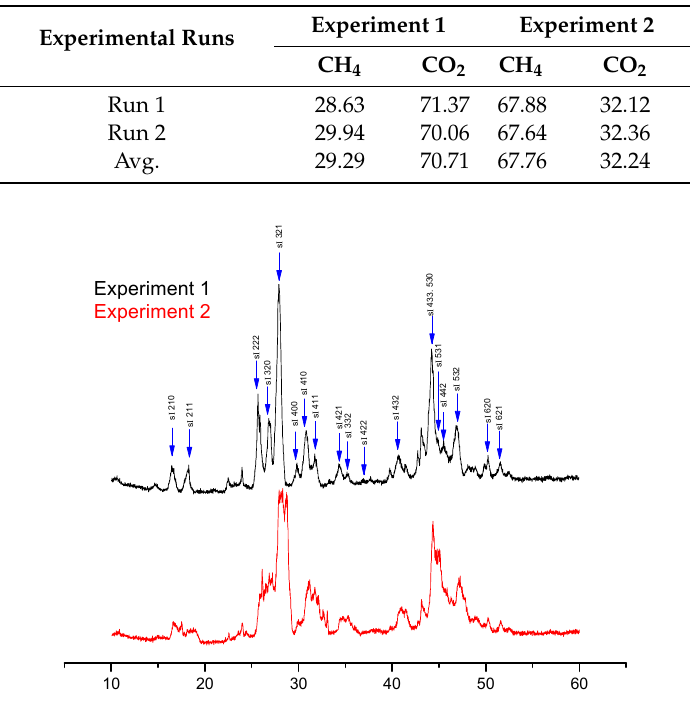
Table 2. Gas compositions in the dissociated gases after the completion of replacements for experiment 1 and experiment 2.